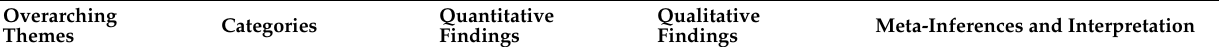
Table 3. An example of the narrative joint display for the theme “impact on